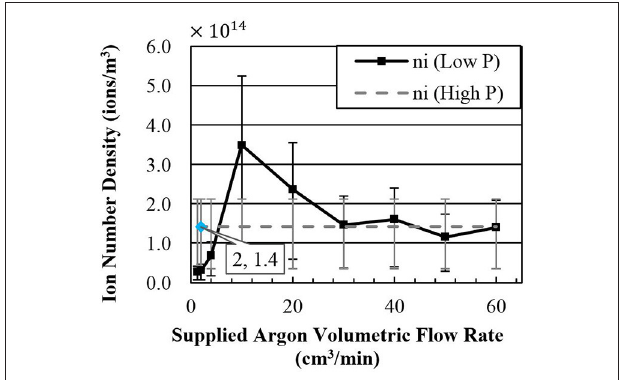
FIGURE 6 | Ion number densities recorded at the “Low-Pressure” (Low P) and 2 cm 3 /min flow rate “High-Pressure” (High P)